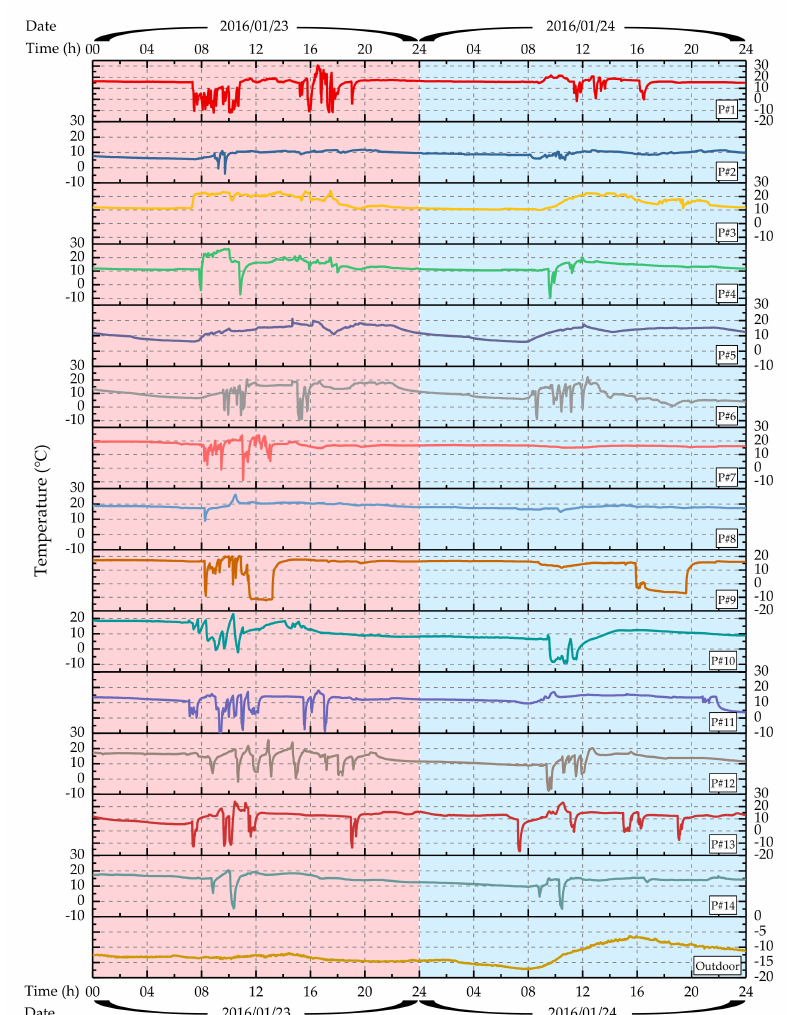
Figure 4. Outdoor air temperature and 14 volunteers’ personal experienced temperatures from January 23rd to 24th, 2016. P#1–14 is the volunteers’ ID number, which coincides with the information in Table